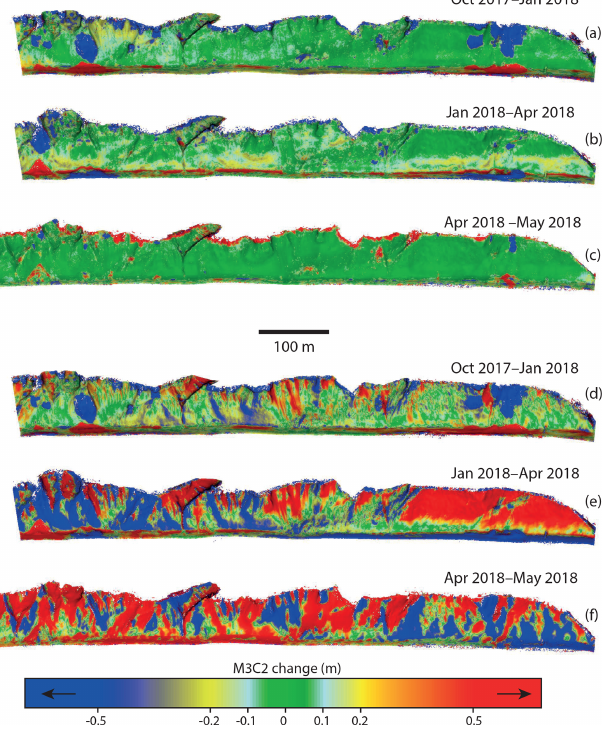
Figure 6. Changes calculated from batch co-alignment of four sur- veys simultaneously. (a–c) M3C2 changes between successive sur- veys following simultaneous co-alignment. In panel (b) bands of change in the lower half of the cliff show more diffuse erosion due to mechanical weathering. (d–f) The same comparisons following the separate processing